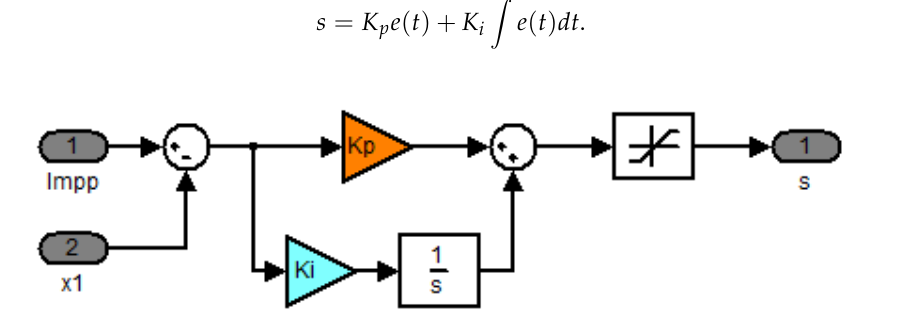
Figure 10. Synoptic diagram of the PI